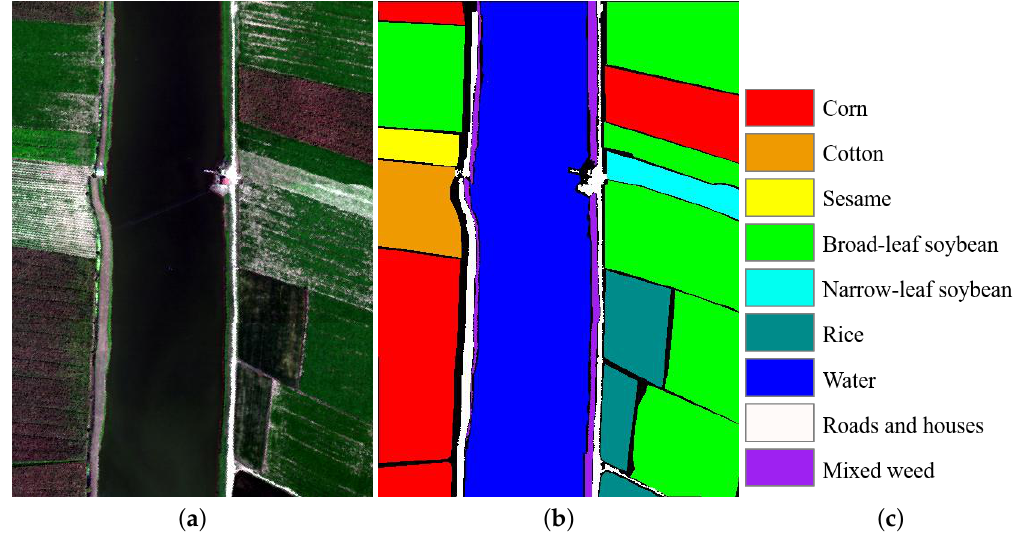
Figure 3. Longkou dataset. ( a ) False color composite. ( b ) Reference image. ( c ) Label name. The Honghu dataset was obtained by a 17-mm focal length Headwall Nano-Hyperspec imaging sensor embedding on a DJI Matrice 600 Pro UAV platform over Honghu City, Hubei province, China. This study region is a complex agricultural scene, which contains different types of crops and different cultivars of the same crop are shown in the area, such as Brassica chinensis and small Brassica chinensis. The flying height of the UAV was 100 m. This image consisted of 270 spectral bands ranging from 0.4 to 1 µ m. The spatial size was 940 × 475 pixels with a spatial resolution of 0.043 m. Figure 4 shows the false-color image and the reference image.